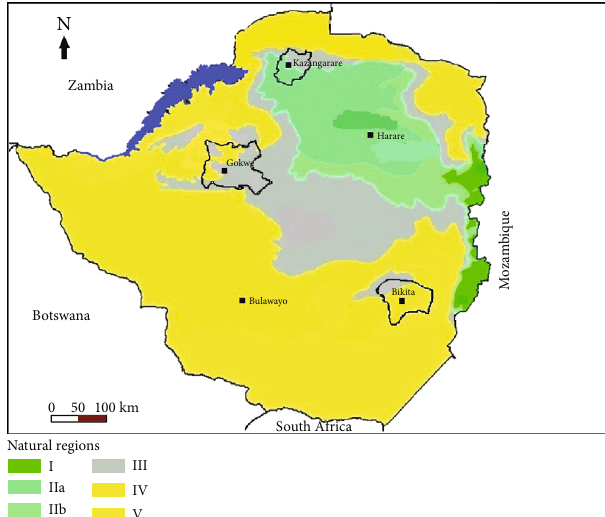
Figure 1: Map showing sampling areas (Bikita, Gokwe, and Kazangarare) of U. kirkiana fruits in